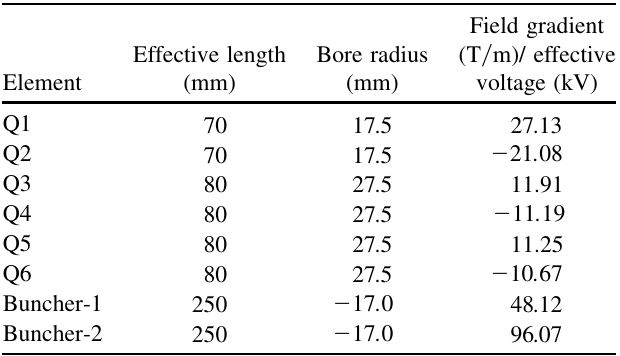
TABLE III. Main parameters of the MEBT1 elements.